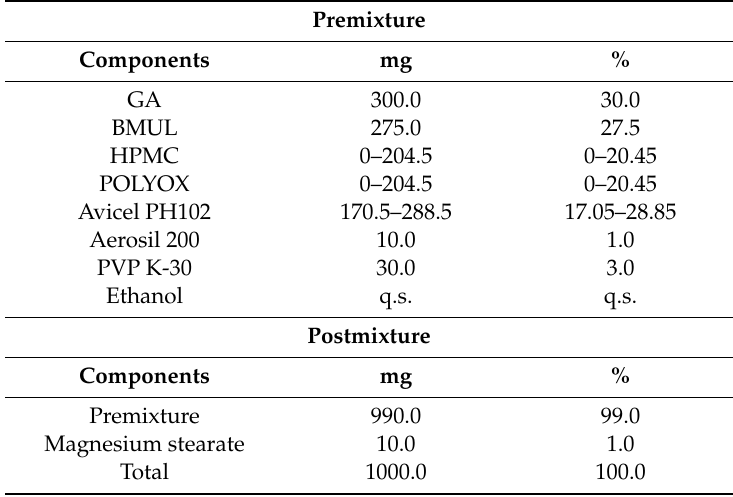
Table 1. Composition of Garcinia cambogia and bioconverted mulberry leaf extract (GABMUL)